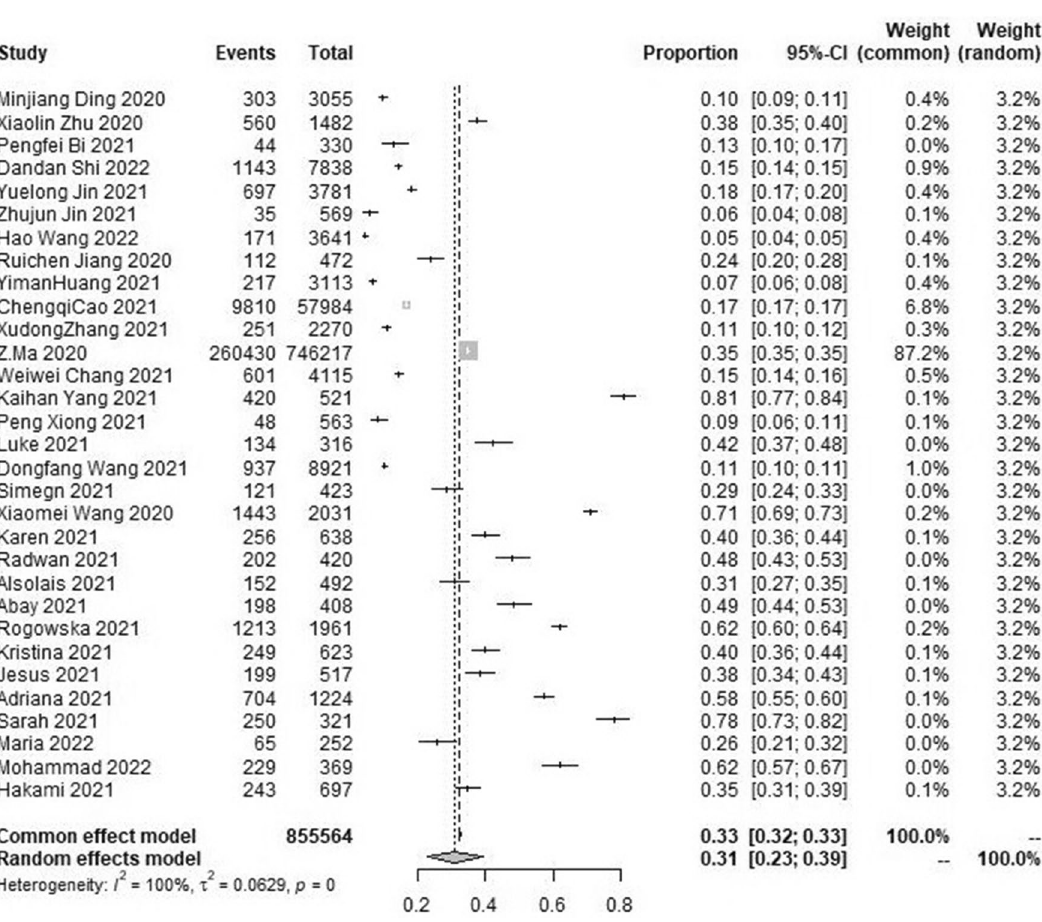
Figure 4. Forest plot of the meta-analysis on prevalence rates of pressure symptoms in the student population.